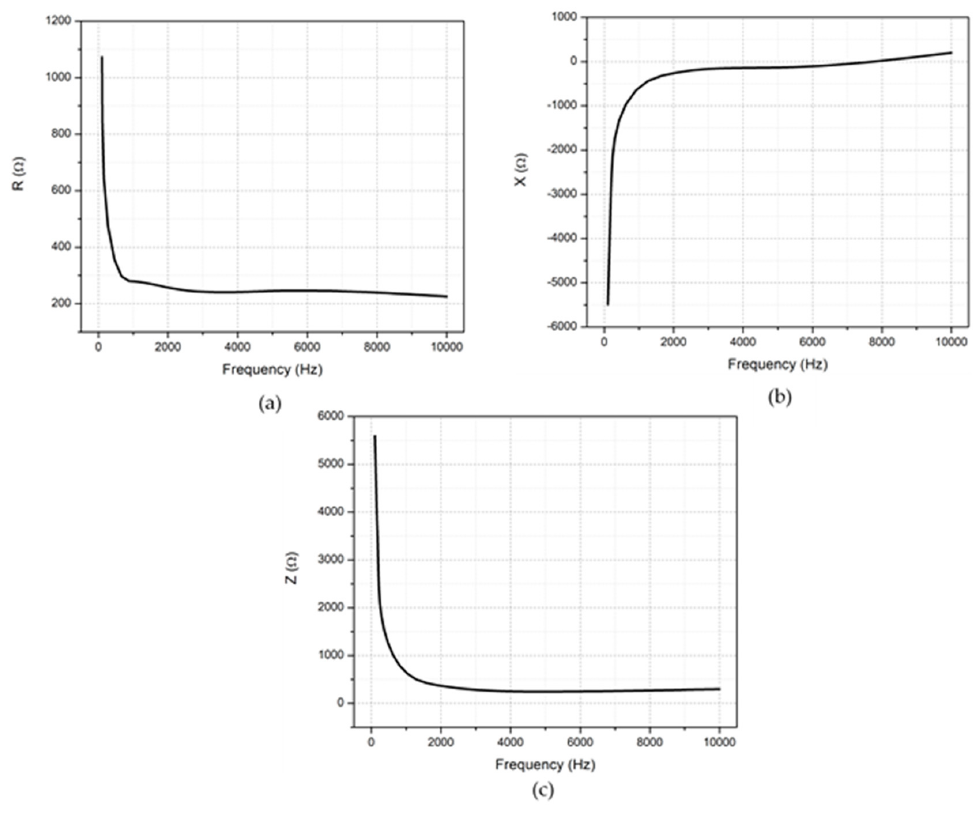
Figure 8. The impedance characteristics of the tactile sensor ( a ) the resistance (R) ( b ) the reactance (X), and ( c ) the impedance (Z) vs. frequency.